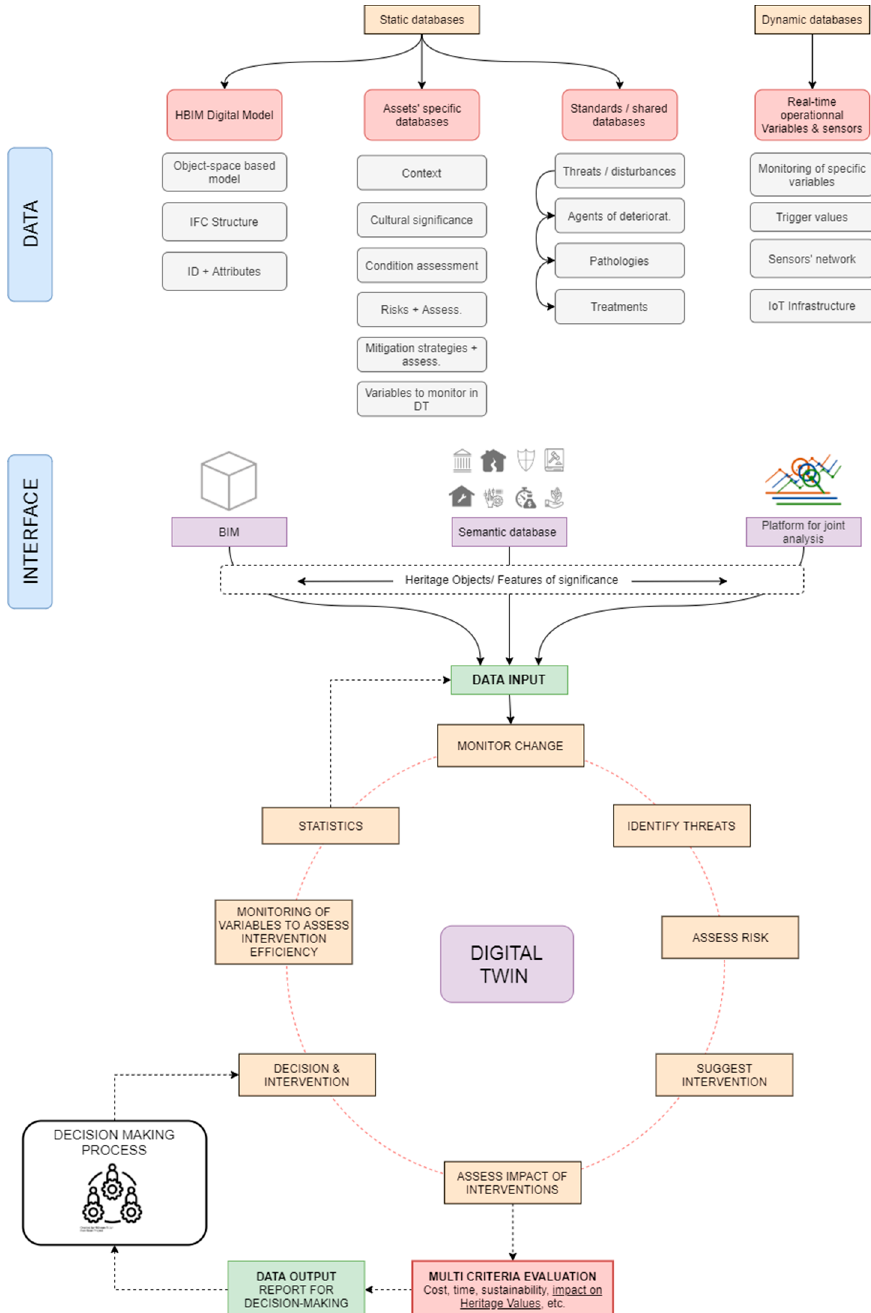
Figure 6. The Digital Twin process to support preventive conservation strategies for the preservation of heritage places.